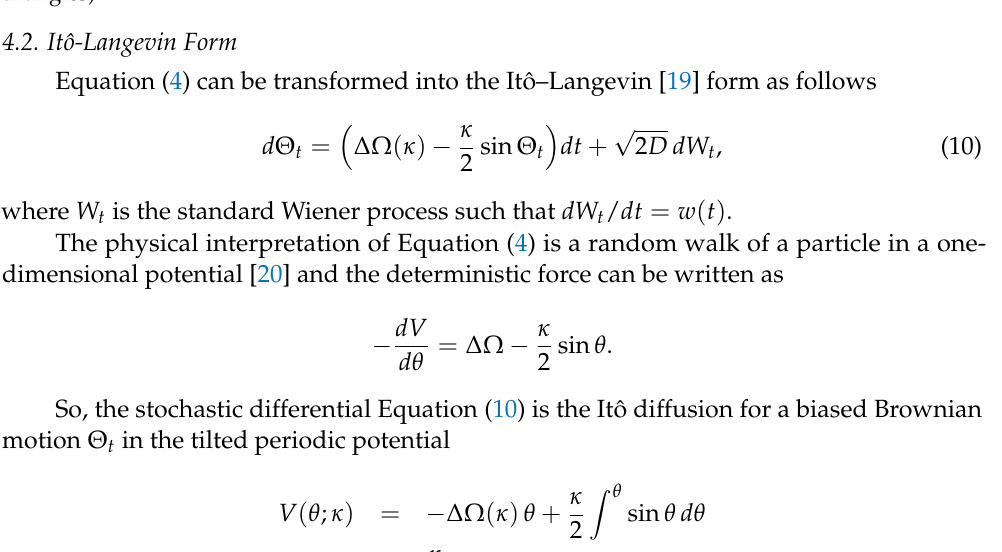
Figure 7. Diffusion coefficient D and mean angular velocity ∆Ω versus coupling strength κ calculated from the time series (blue circles) and from the averaged difference of dominant frequencies (orange